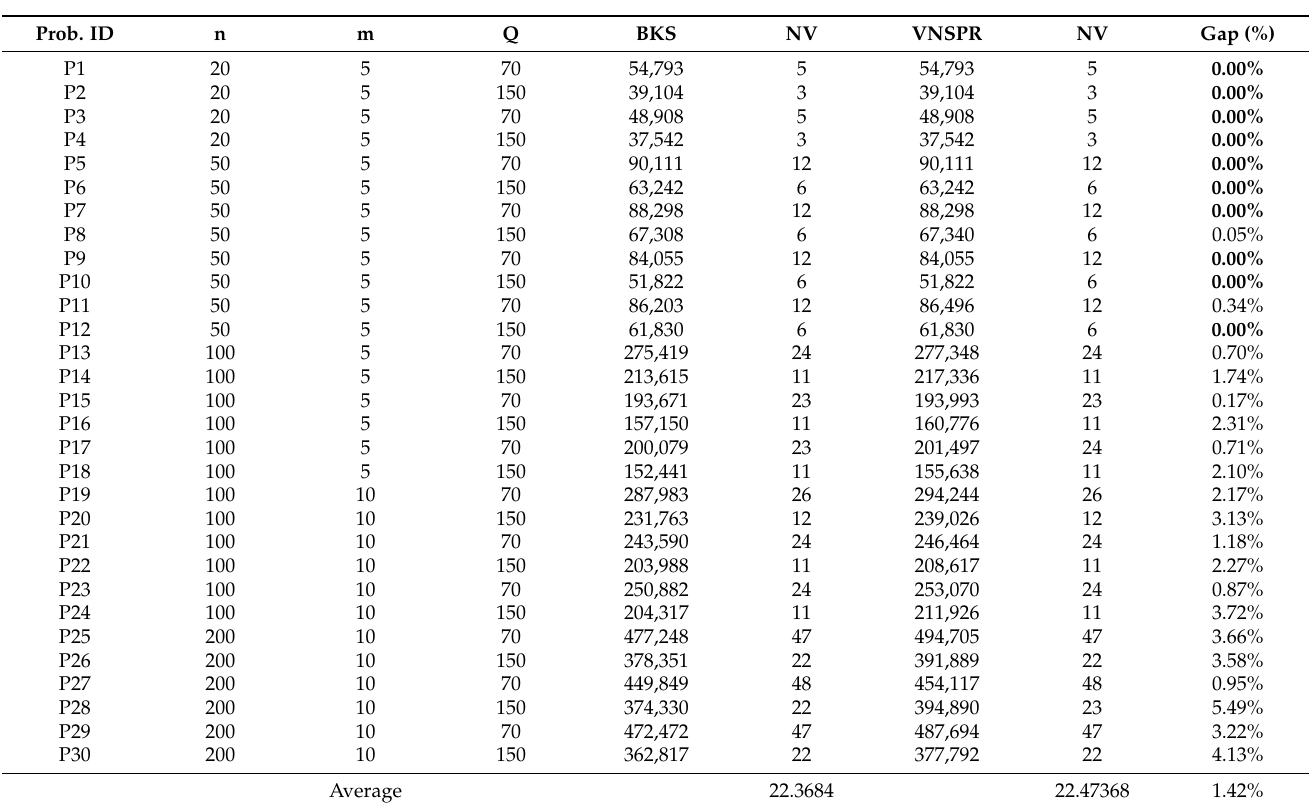
Table 7. Computational results LRP with time windows for Prins et al.’s